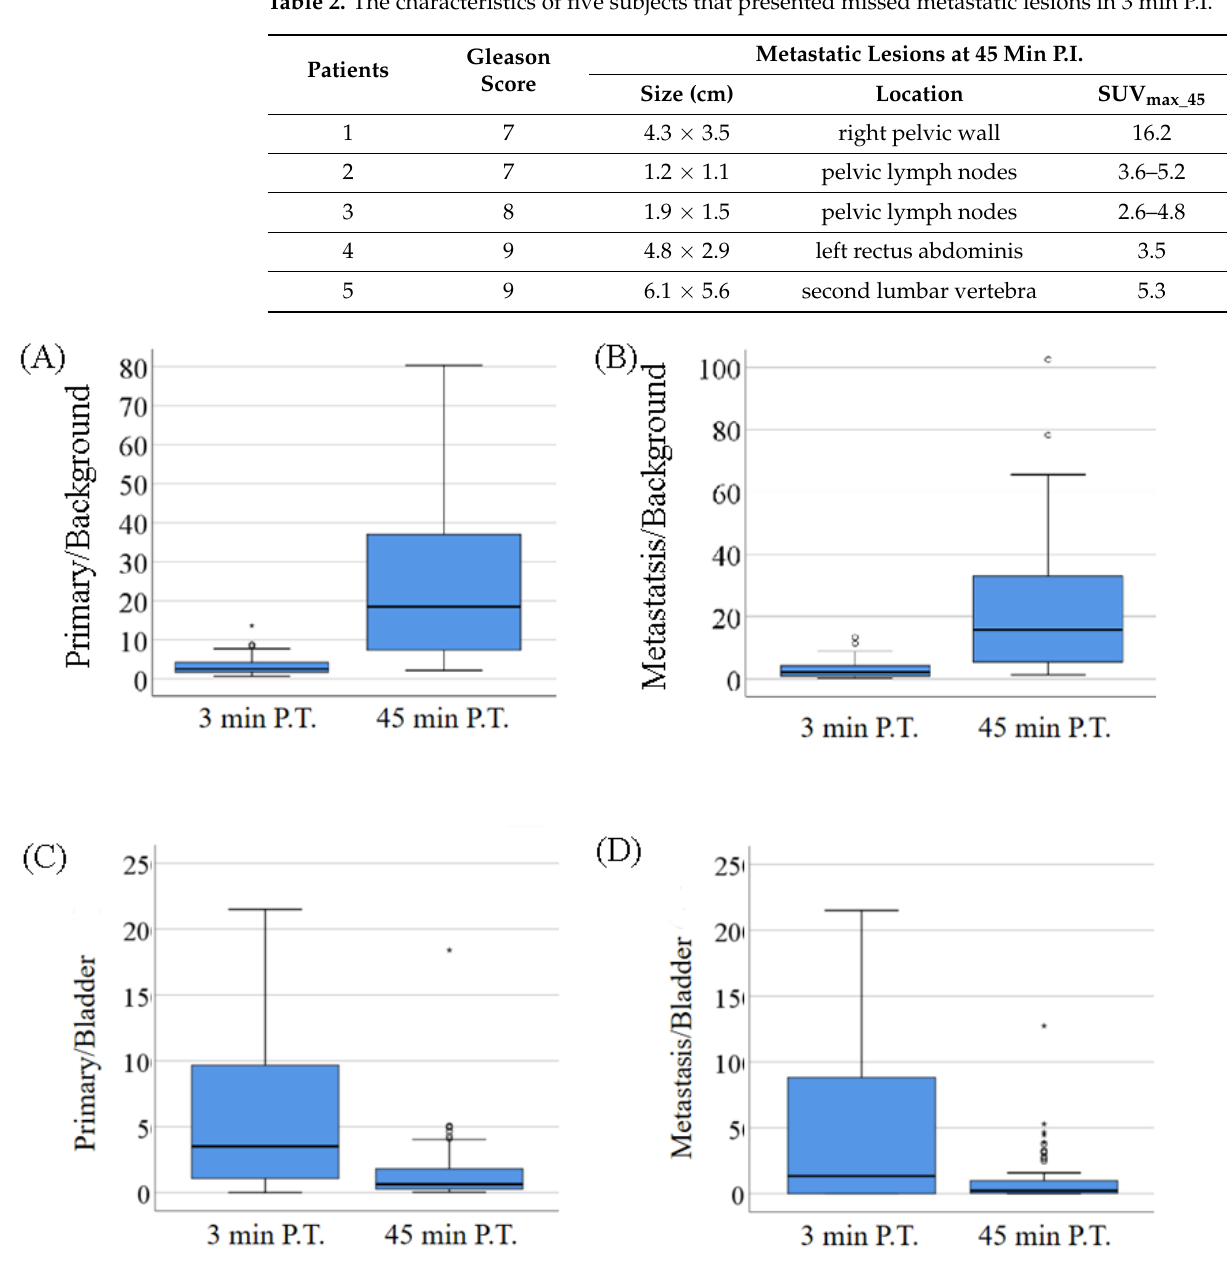
Figure 3. Box–whisker plots of the main findings, including tumor to background ratios of the primary lesions ( A ), metastases ( B ), and tumor to bladder ratios of the primary ( C ) and metastases ( D ). The T/BL values higher than 25 are not displayed in figures.